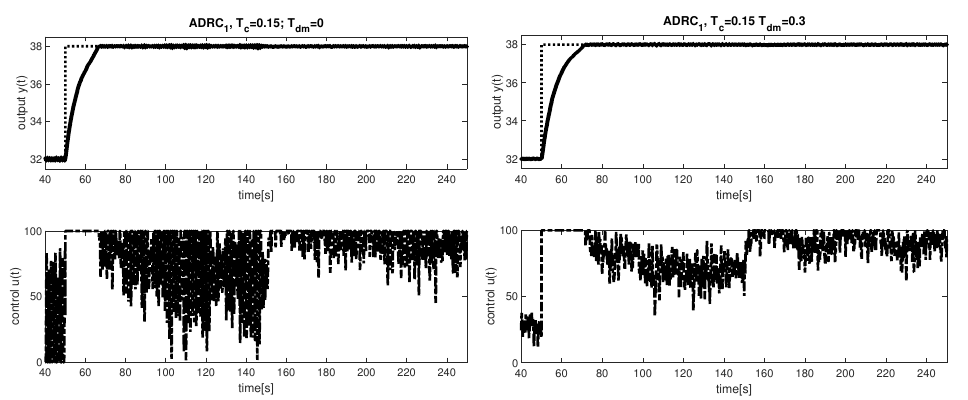
Figure 5. ADRC 1 : Plant input and output for T c = 0.15 with T dm = T d = 0 ( left ) and T dm = T d = 0.3 ( right